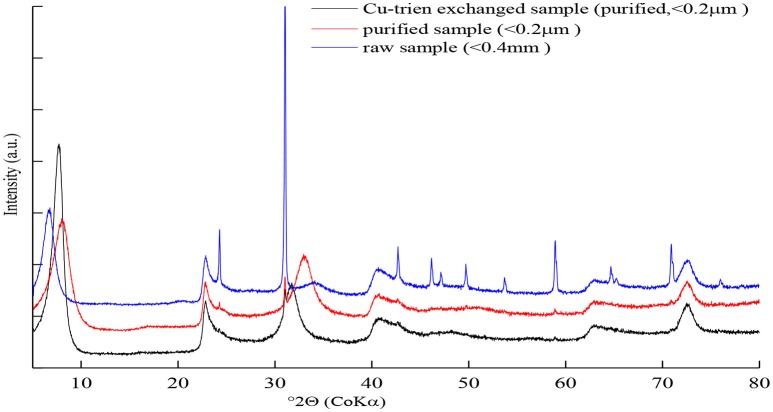
The XRD patterns of the sample NWa with different cation exchange states.